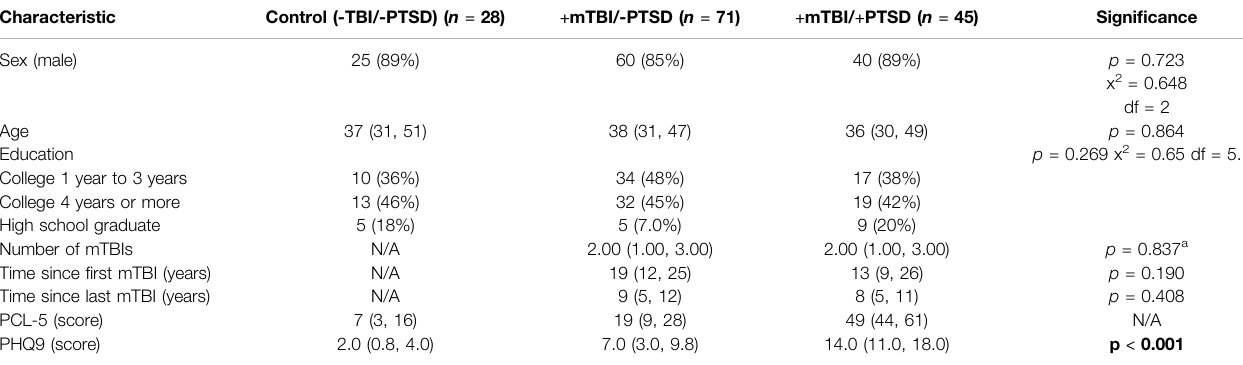
TABLE 1 | Demographic and clinical characteristics. Characteristic Control (-TBI/-PTSD) ( n =